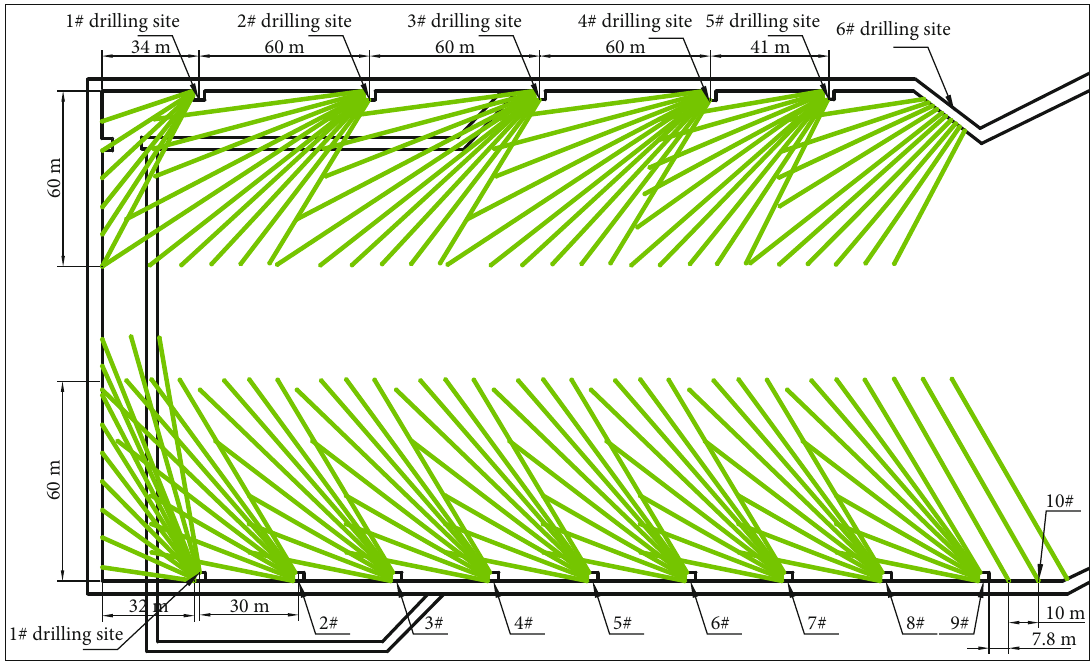
Figure 19: 13817 fl oor drilling layout plan of mining